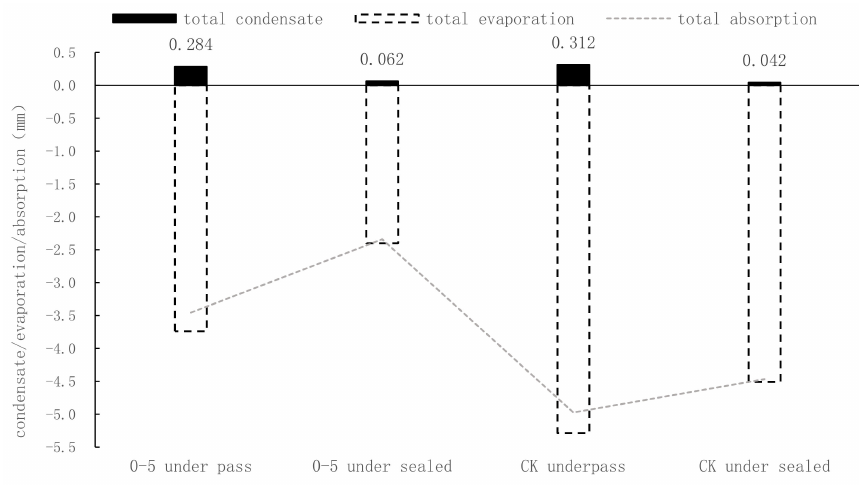
Figure 4. Condensate generation